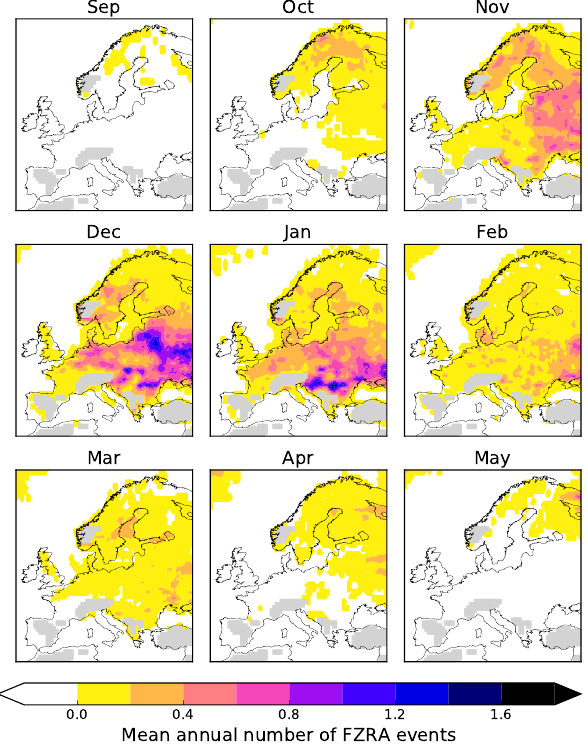
Figure 10. The monthly climatology of FZRA in 1979–2014 ac- cording to the FMI CLIM algorithm, applied to the ERA-Interim. The average annual number of 6h FZRA cases is shown. The high- est elevations were excluded (grey) because of larger uncertainties in FZRA